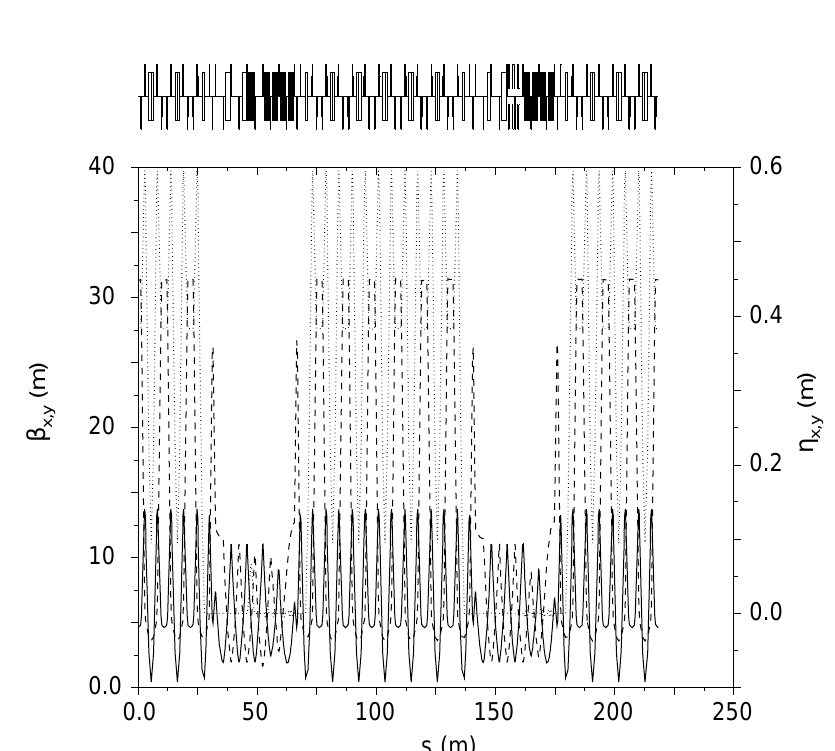
FIG. 16. Optical functions of the entire PDR. The wigglers are the two darkened areas.